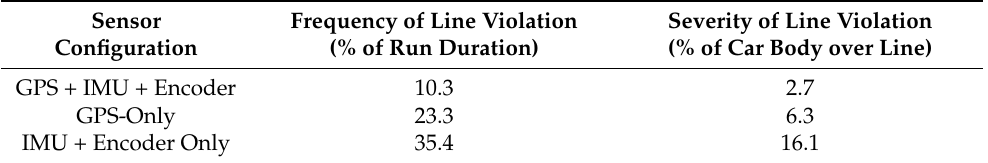
Table 3. Downstream evaluation of state estimation averaged over four runs for each state estima- tion